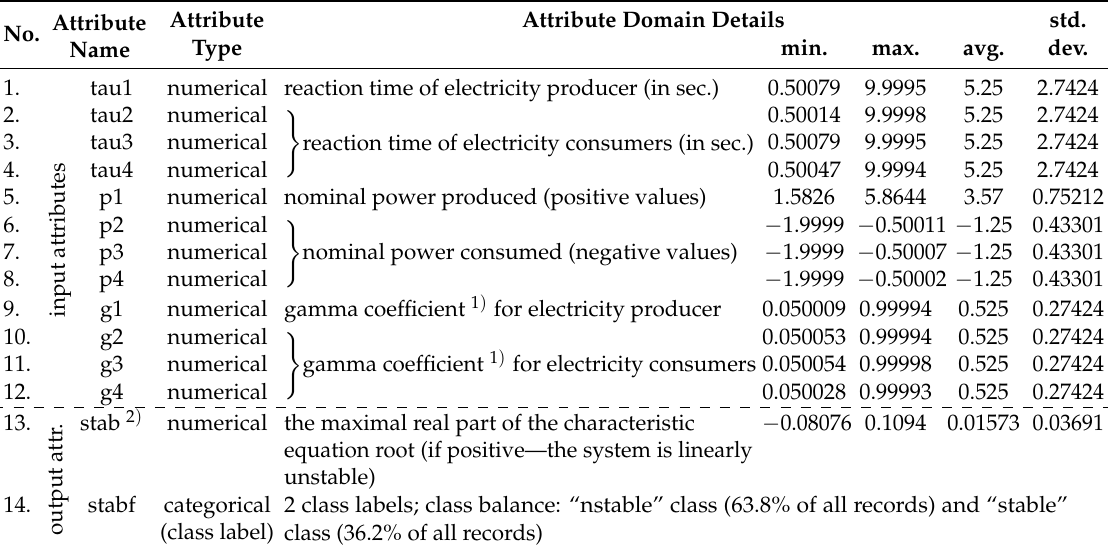
Table 1. Details of particular records of the Electrical Grid Stability Simulated Data Set used in our experiments.